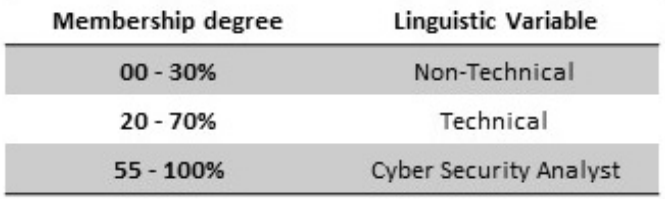
Figure 5. Input 1